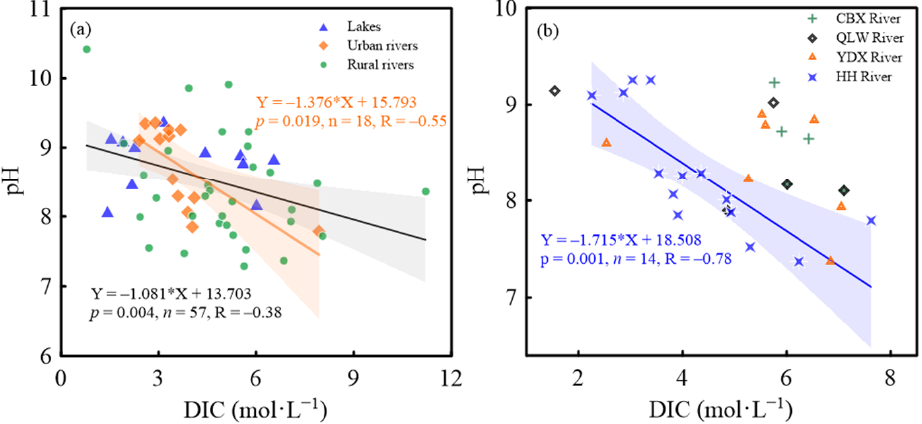
Figure 6. Correlations between DIC and pH in diverse river waters in Tianjin. ( a ) All the river waters; ( b ) Chaobaixin (CBX) River, Qinglongwan (QLW) River, Yongdingxin (YDX) River, and Haihe (HH) River.